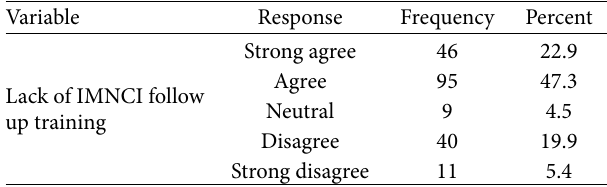
Table 13: Supervision.